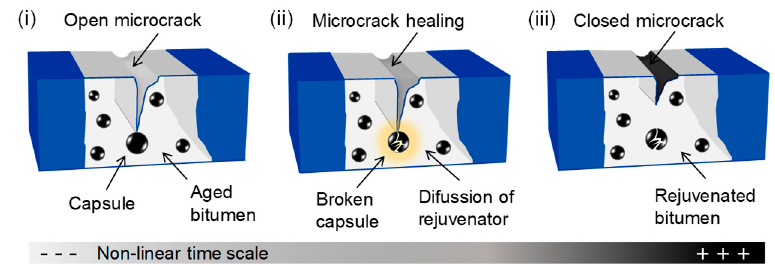
Figure 1. Concept of autonomic crack-healing in asphalt over time using encapsulated rejuvenators. Depending on their structure, capsules can be classified as either spherical polynuclear capsules or core-shell capsules [10], consisting of a defined core/cargo surrounded by a polymeric shell structure.